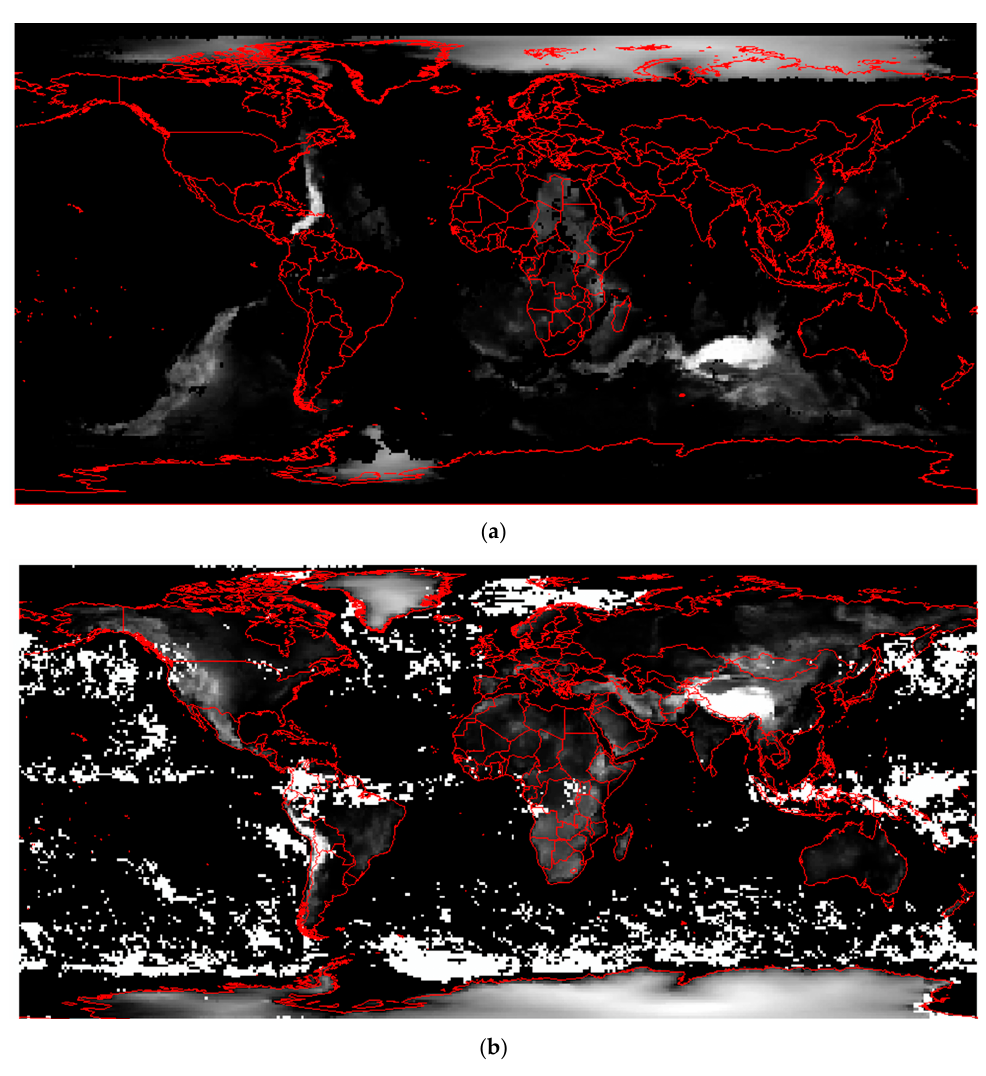
Figure 12. Image 180 degree rotated ( a ) compared to the correct interpretation ( b ) after